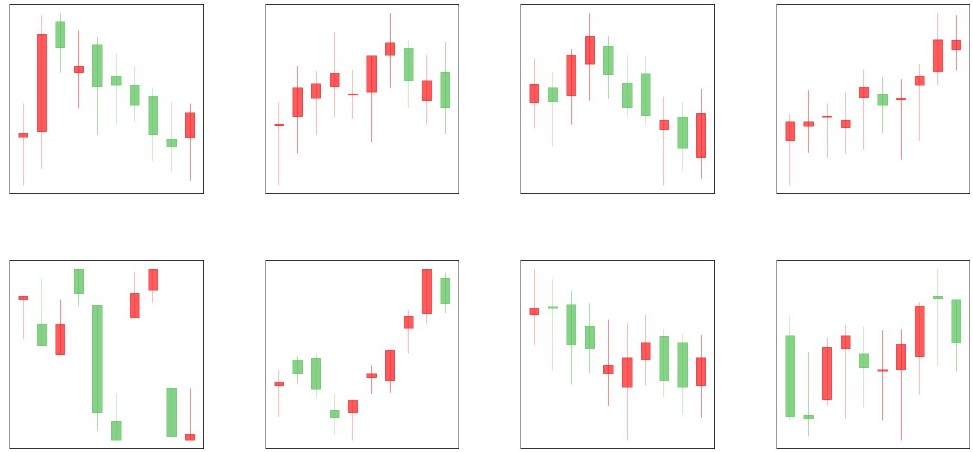
Figure 1. The candlestick charts. The red indicates a price increase; the green shows a price